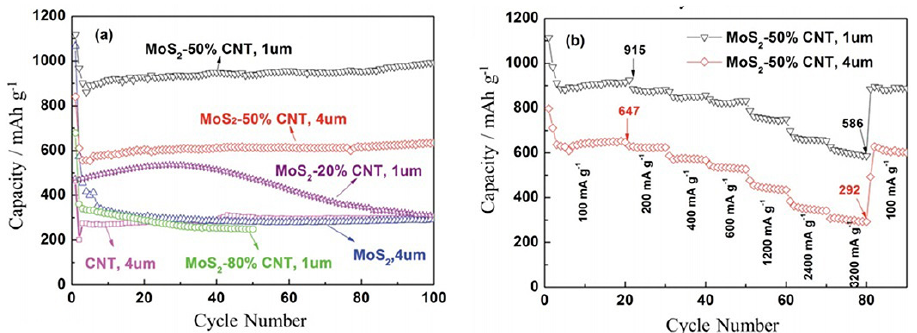
Figure 2. ( a ) Electrochemical performance of SWNT, MoS 2 , and MoS 2 –SWNT films between 0.01 and 3.0 V vs. Li/Li + at a cycling rate of 100 mA g − 1 , and ( b ) rate capacities of MoS 2 –SWNT (50%) films with a thickness of 1 µ m and 4 µ m. Reprinted (adapted) with permission from Reference [89], Copyright (2013), Wiley.